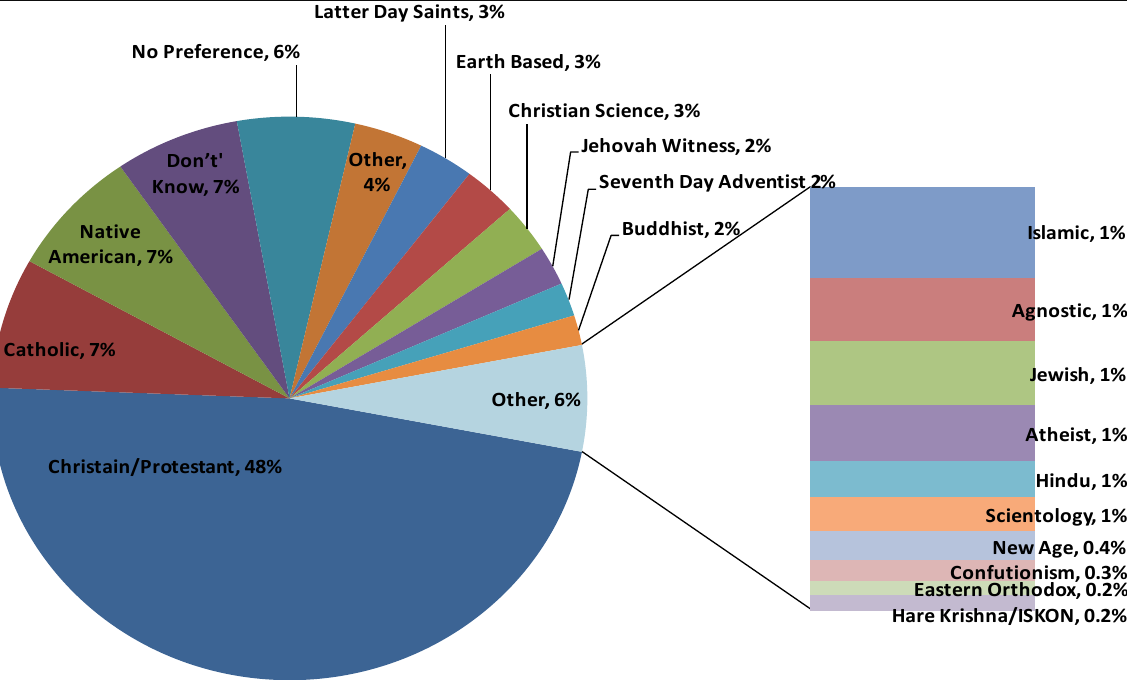
Figure 1. Humanist, Spiritual and Religious Affiliation at Prison Intake (N =